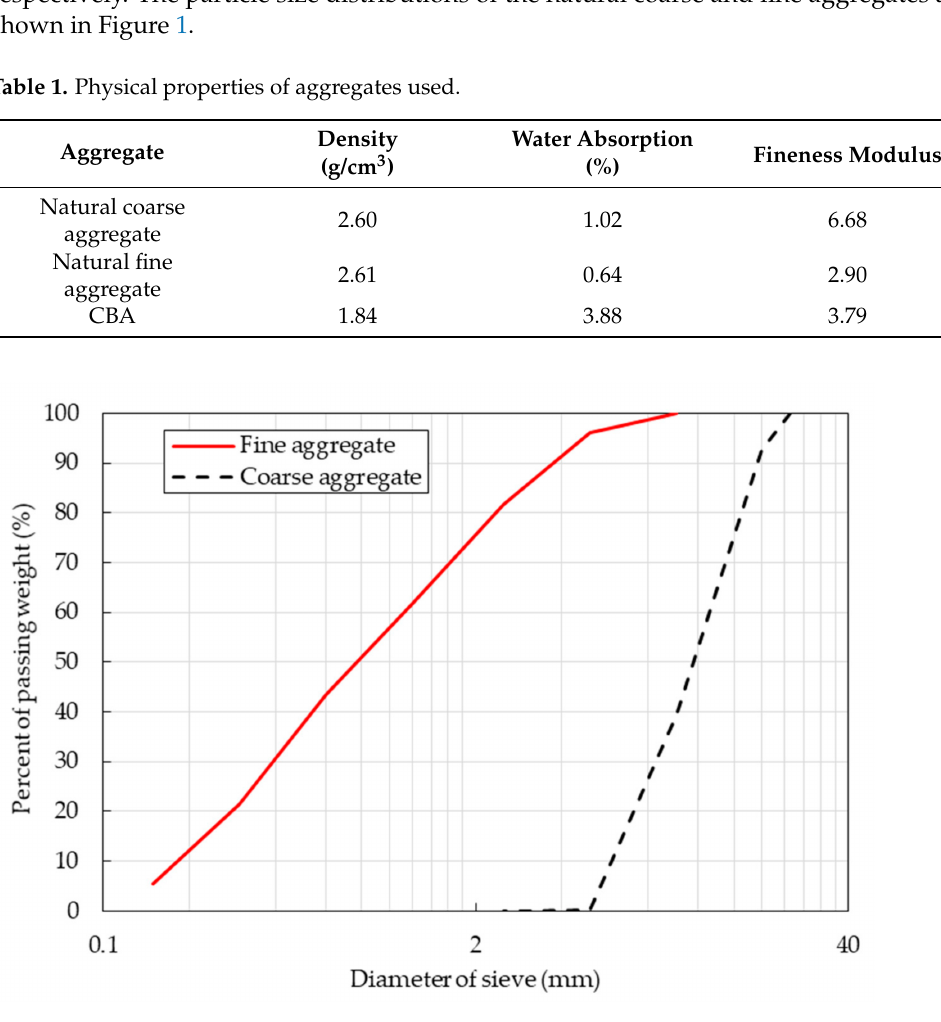
Figure 1. Sieve analysis results of the natural coarse and fine